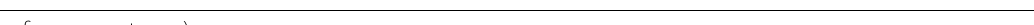
began(See figure on next Fig. 10 Tectonic evolution scenarios. a Paleo-Asian Ocean northward subduction in early Paleozoic. The Southern Mongolia microplate and the North China Craton began to convergent. b Paleo-Asian Ocean began southward subduction in middle and late Paleozoic. The pattern of bidirectional subductions has been formed. c Continental collision in late Paleozoic and early Mesozoic. The Paleo-Asian Ocean has been closed in the Solonker Suture Zone. d Post-collisional extension in middle and late Mesozoic. A larger scale of thermal material was upwelling. Baiyinuoer and other mineral concentration areas began to form. e Intra-continental deformation from late Mesozoic to the present. The lithosphere has been thinned in the North China Craton. The subduction of Paleo-Pacific Plate